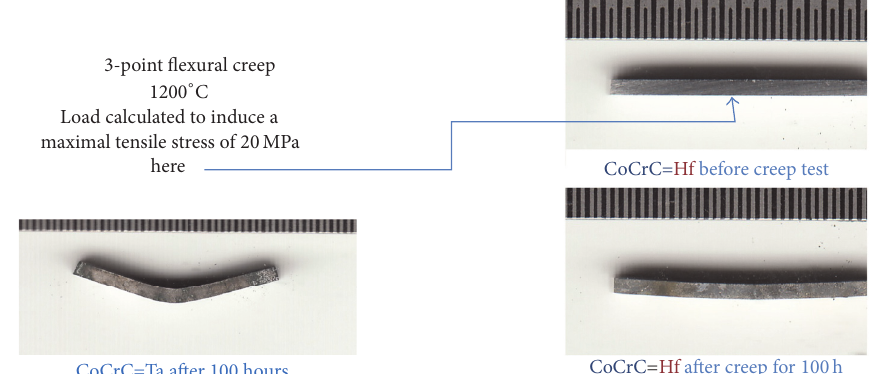
Figure 8: Deformed and oxidized states of the “CoCrC=Ta” alloy (25 hours before contact, left) and of the “CoCrC=Hf” alloy (after 100 hours, right) after creep test at 1200 ∘ C under a load applied on the top middle to induce a 20 MPa tensile stress.